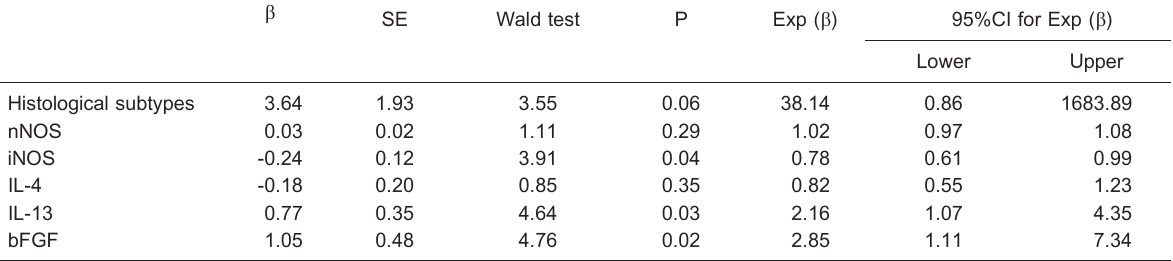
Table 3. Cox proportional hazards regression to ascertain the individual contribution of histological subtypes and morphological factors associated with survival and to compare adjusted survival between the groups [-2 log likelihood=35.15; chi square=21.36; P , 0.002]. b